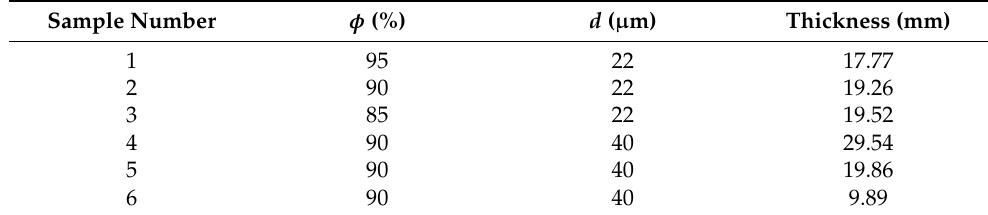
Table 2. Physical parameters of six sintered metal fibre